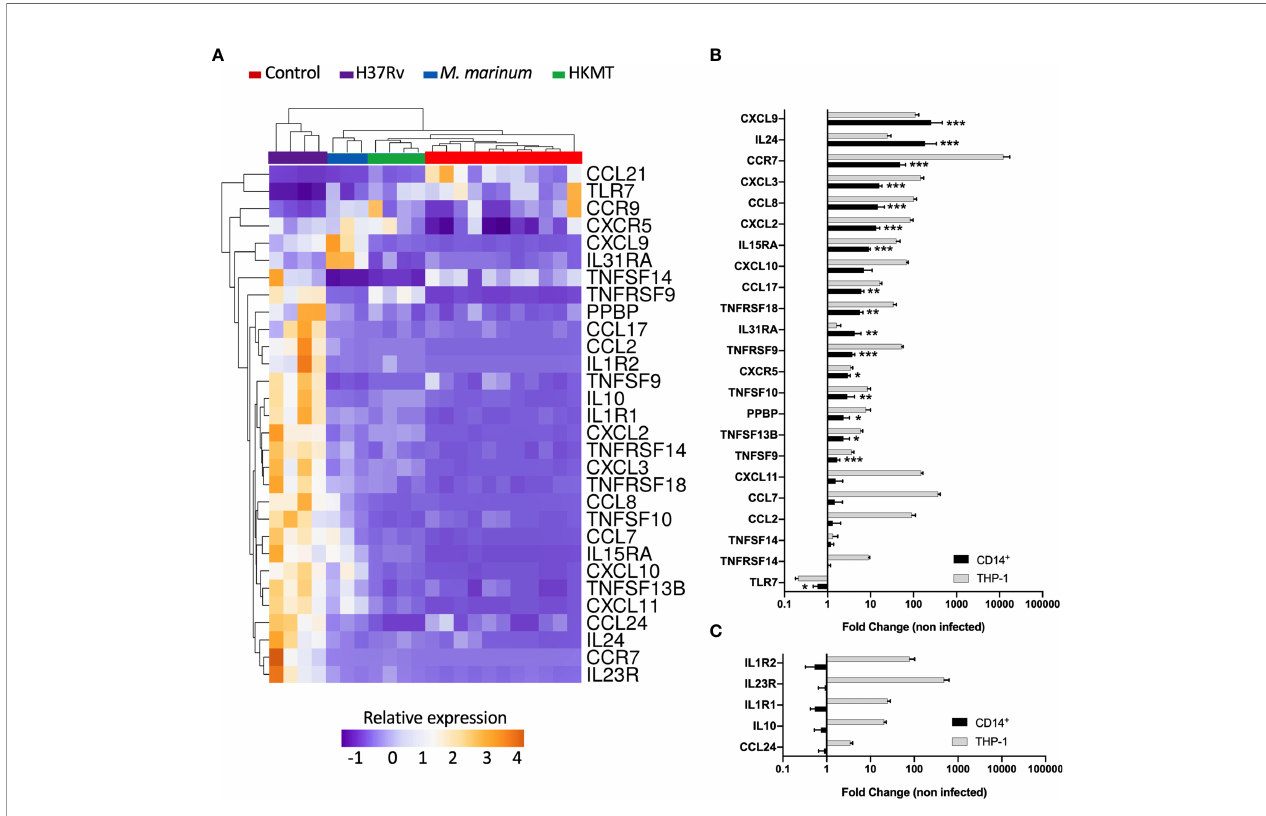
FIGURE 2 | Infection with H37Rv led to a speci fi c and signi fi cantly different host in fl ammatory response. (A) THP-1 differentiated into macrophages were infected with H37Rv, M. Marinum or stimulated with HKMT for 48 hours, then total RNA was extracted and the expression level of the 184 host immune response-related genes were quanti fi ed using RT-PCR (n = 11 control, n = 3 M.marinum , n=4 HKMT and H37Rv). For each experiment with the different mycobacterial strains, uninfected macrophages were used as control, independently. Using Clustvis software, a supervised hierarchical clustering was generated for the 98 genes with CT value below 32. Supervised hierarchical clustering of macrophage samples distribution depending on the relative expression of genes that were signi fi cantly deregulated by H37Rv infection as compared with both M. marinum infection and HKMT stimulation. Statistical analysis was performed on DD Ct using ANOVA and multiple comparisons. Imputation was used for missing value estimation. Samples were clustered using the correlation distance method and average linkage. (B, C) THP-1 and CD14 + MDM were infected with H37Rv for 48 hours, then total RNA was extracted and the expression level of the 30 H37Rv-speci fi c host in fl ammatory response was quanti fi ed using RT-PCR (n = 4). Graphs represent gene expression fold change compared to uninfected cells. Statistical analysis was performed on DD Ct using Student ’ s t-test. *p value < 0.05, **p value < 0.01, ***p value <